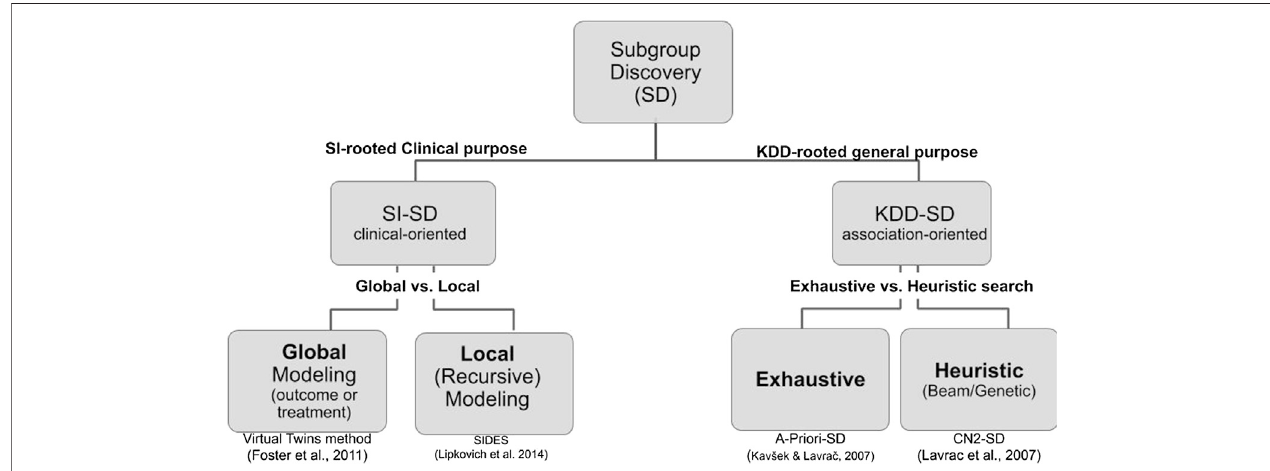
FIGURE 3 | Hierarchical tree representing the SD approaches in both biomedical data analysis and data mining cultures. The references under the boxes correspond to representative algorithms of each